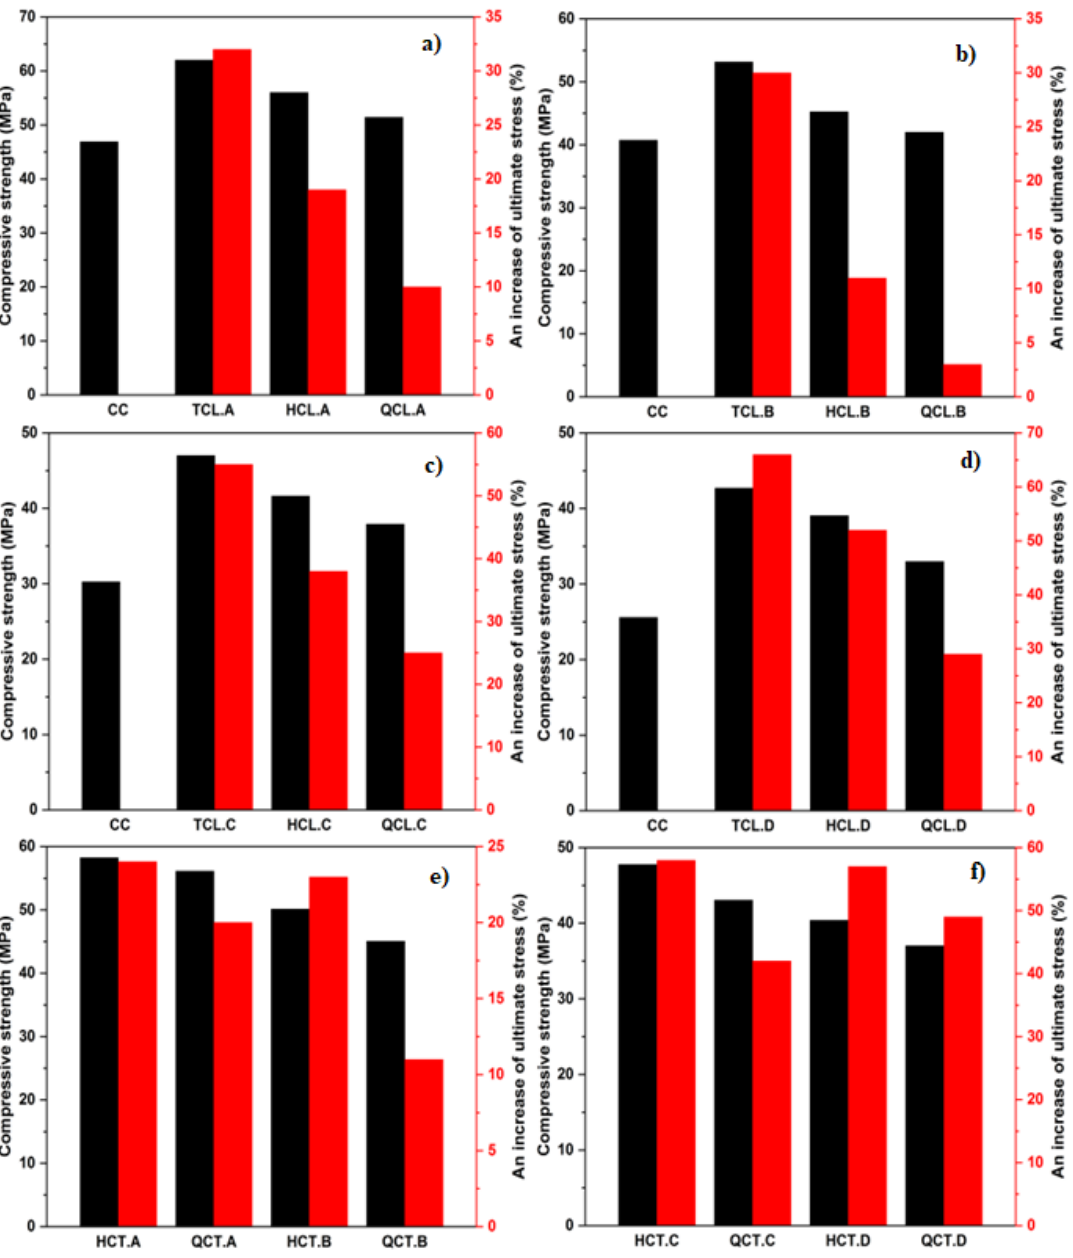
Figure 7. Volumetric ratio effect: ( a ) longitudinal confinement of 0.33 W/C ratio; ( b ) longitudinal confinement of 0.36 W/C ratio; ( c ) longitudinal confinement of 0.401 W/C ratio; ( d ) longitudinal confinement of 0.522 W/C ratio; ( e ) transversal confinement of 0.33 and 0.36 of W/C ratios; and ( f ) transversal confinement of 0.401 and 0.522 of W/C ratios. An increase in ultimate compressive stress compared to control specimens from 3% to 66% was induced for W/C ratios ranging from 0.33 to 0.522 with a change in a volumet- ric ratio of 0.025, 0.01, and 0.0046. It is noticed that the strength gain of the confined